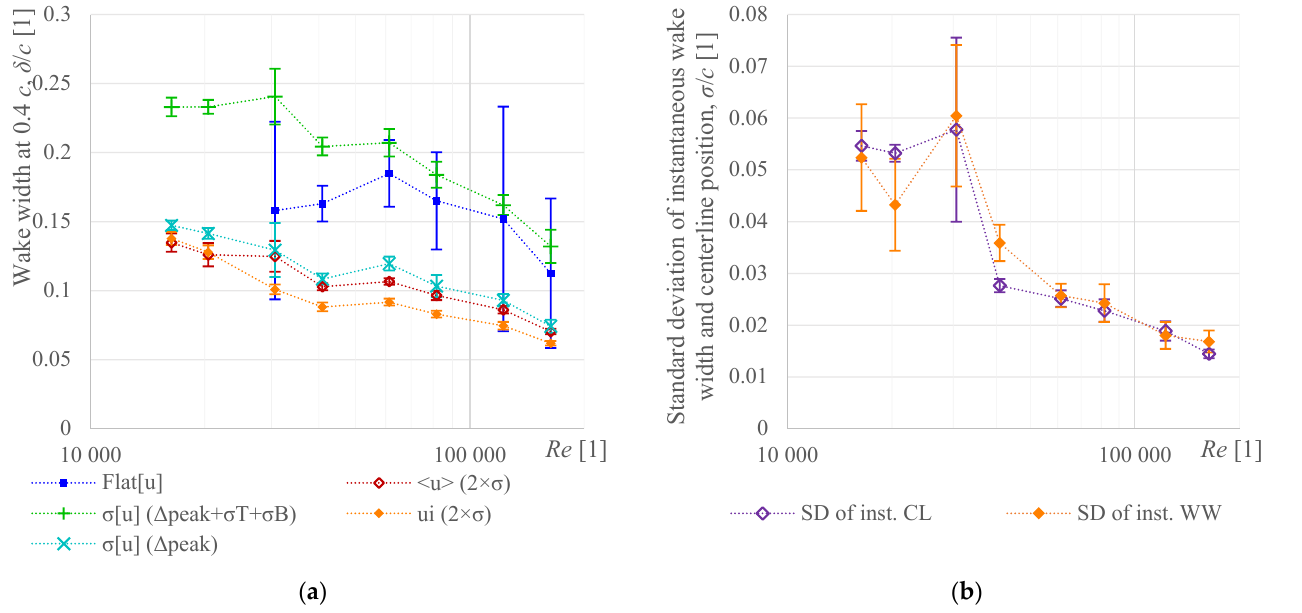
Figure 14. ( a ) Comparison of possible wake width definitions at distance x / c = 0.4 past the airfoil NACA 64-618 trailing edge as a function of chord-based Reynolds number. Empty maroon diamonds denote the Gaussian fitting of average velocity profile, filled orange diamond the Gauss fitting of instantaneous velocity fields, the green crosses represent wake width based on peaks of stream-wise velocity standard deviation, cyan Xs represent the fluctuation peak distance only, and the blue squares represent the threshold of stream-wise velocity flatness, which fails for laminar flow, therefore, it is not plotted there. ( b ), Standard deviation of the instantaneous wake width calculated by using Gaussian fit (orange filled diamonds) and the standard deviation of the wake centerline position (violet empty diamonds), which can be interpreted as wake meandering.